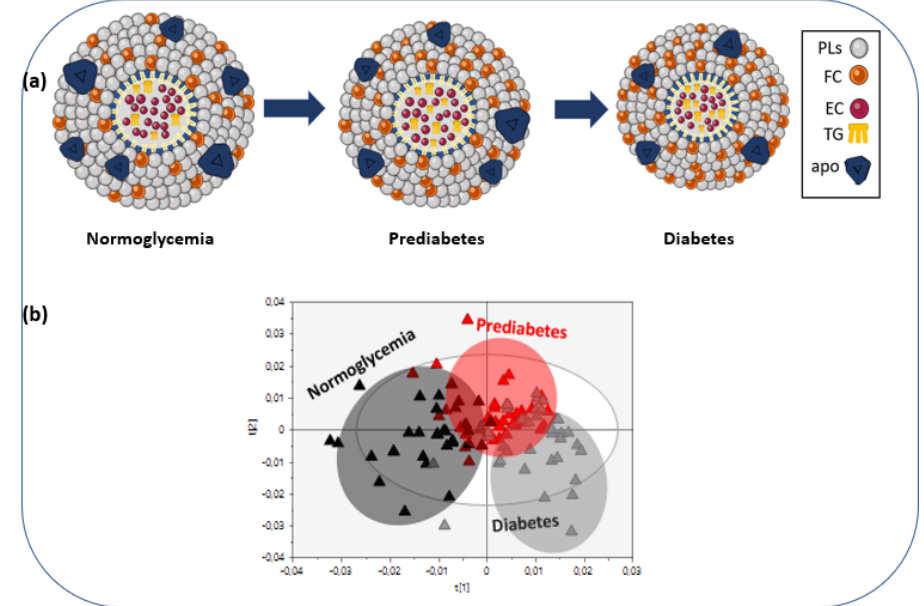
Figure 2. ( a ) HDL particles in the normoglycemic group, patients with prediabetes and type 2 diabetes, ( b ) OPLS-DA scores plot of the HDL lipidomic data from the normoglycemic group (black triangles), patients with prediabetes (red triangles) and those with T2D (gray triangles).